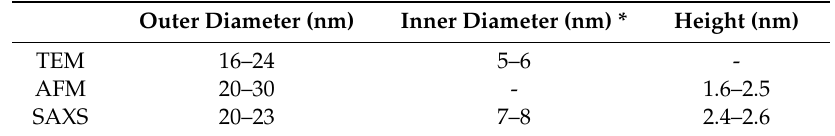
Table 1. Summary of structural parameters of the stab-1 HCC oligomers obtained by di ff erent experimental